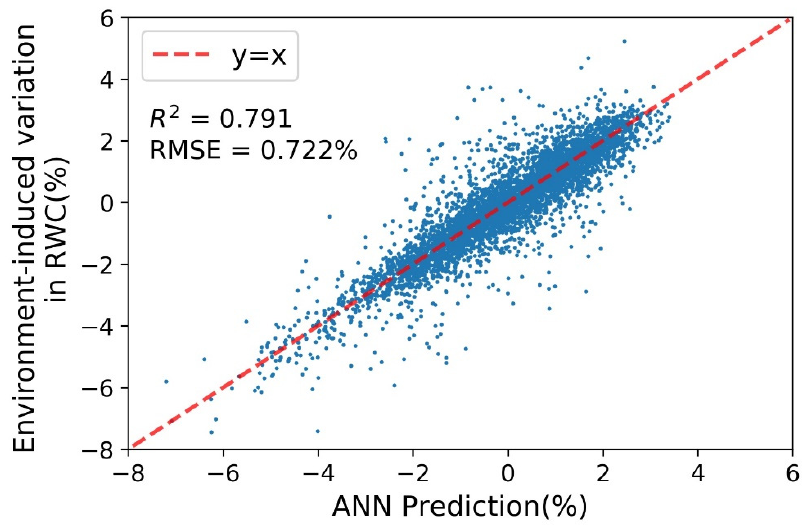
Figure 9. The five-fold cross-validated prediction results of environment-induced variation in pre- dicted RWC for the sample dataset (G1H). The ANN prediction values show a significant performance with R 2 = 0.791 and RMSE = 0.722%.